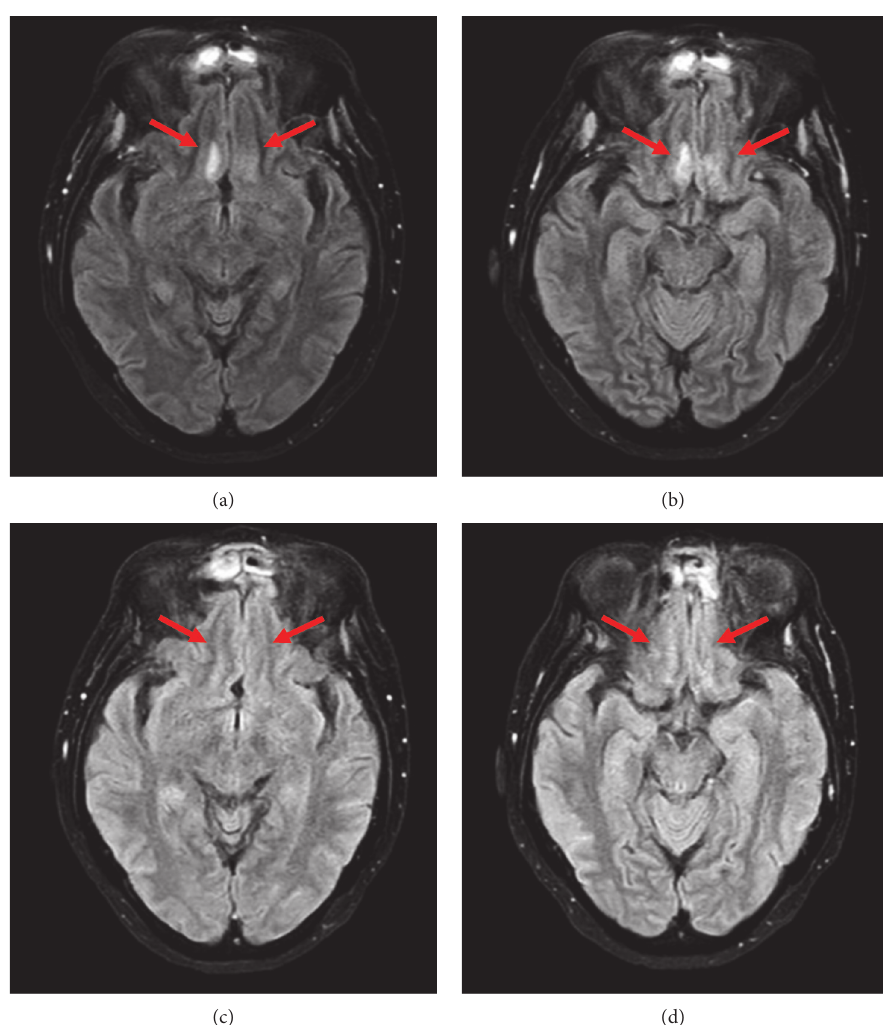
Figure 4: (a, b) FLAIR sequence showed hyperintense signal in cortical anterobasal frontal lobes (arrows) at the beginning of the treatment (first week). (c, d) FLAIR sequence showed reduced hyperintense signal in cortical anterobasal frontal lobes (arrows) at 5 months